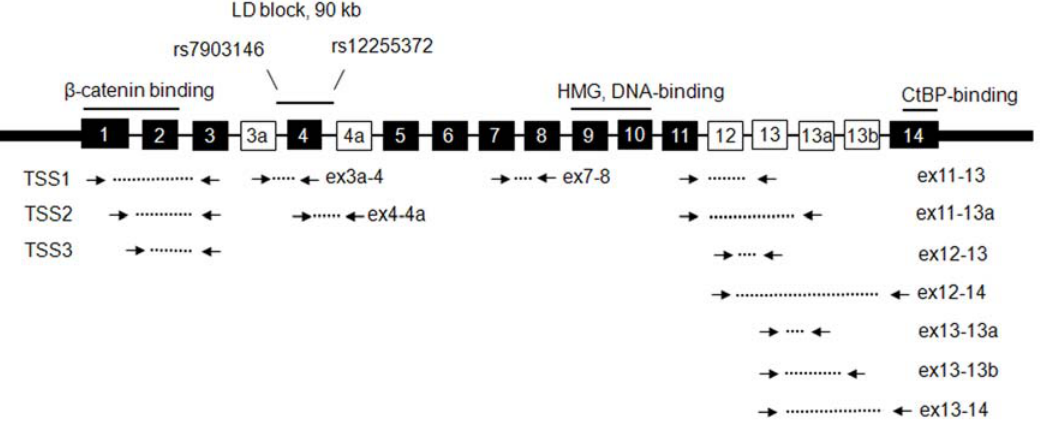
Figure 1. Structure of TCF7L2 gene and location of expression assays. The scheme shows constitutive exons (black rectangles), alternative exons (white rectangles); linkage disequilibrium (LD) block with associated SNPs rs7903146 and rs12255372; protein domains: ß-catenin-interacting domain, DNA-binding HMG domain and C-terminal Binding Protein (CtBP)-binding domain; expression assays for detection of alternative splicing forms of TCF7L2 are indicated by connected arrows: assays TSS1, TSS2 and TSS3 target transcripts produced from alternative transcription start sites while other assays target alternatively spliced forms with different combinations of exons, * - expression of assay ‘‘ex13-13b’’ was tested but not detected in adipose